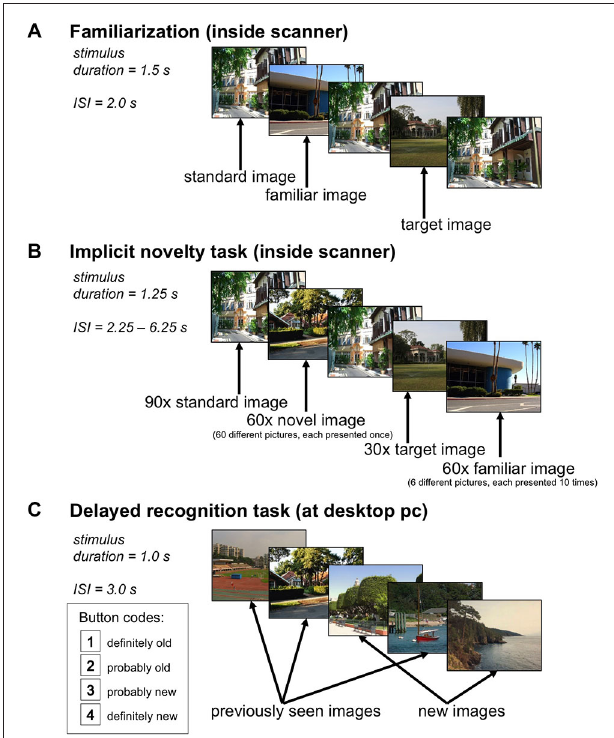
FIGURE 1 | Experimental Paradigm . (A) In the familiarization phase, a standard image and a target image were presented 66 times each, and six additional pictures were presented ten times each, the latter ones serving as rare familiar stimuli in the main experiment. (B) During the implicit novelty task, 60 novel images were presented randomly intermixed with 60 familiar images (each familiar stimulus was repeated 10 times), 90 repetitions of the